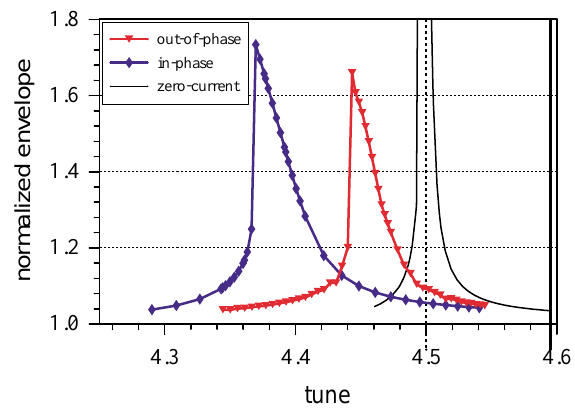
FIG. 3. (Color) Maximum y envelope excursions for three mag- nitudes of focusing errors with fixed (cid:3) n 0 x , n 0 y (cid:4) (cid:1) (cid:3) 6.45, 4.6 (cid:4) as a function of normalized tune shift (intensity parameter I with I (cid:1) 1.635 indicating the small-amplitude envelope resonance condition and I (cid:1) 1 indicating the single-particle resonance). The result of the exact numerical solution of the envelope